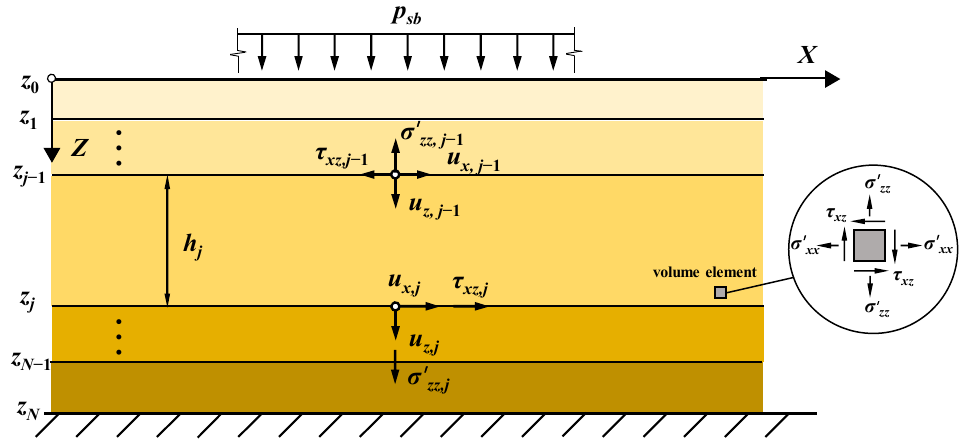
Figure 2. A multilayered TIP seabed subjected to hydrodynamic pressure.